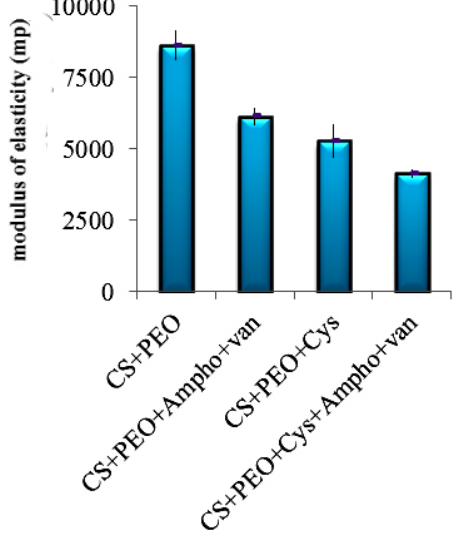
FIGURE 5 - DMA analysis of free and drug-loaded